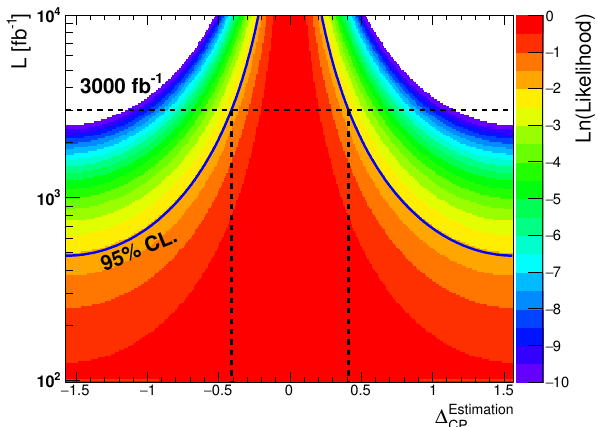
Figure 5 . Required integrated luminosity at the 14 TeV LHC, for achieving di(cid:11)erent values of the binned log-likelihood as a function of (cid:1). The projected 95% C.L. exclusion contours are shown by the solid blue